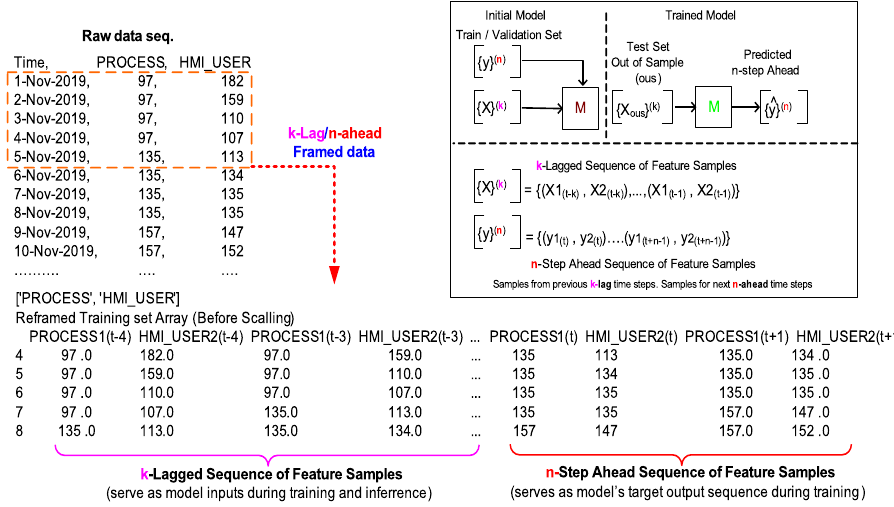
Figure 14. Snippet of raw time-series data set generated from ht -MI application. PROCESS and HMI_USER values are restricted to 8-bit integers (arbitrary time stamps generated). The raw data series are framed into supervisory training data as desired for source ( k-lag ) and target ( n-ahead ) length of sequence